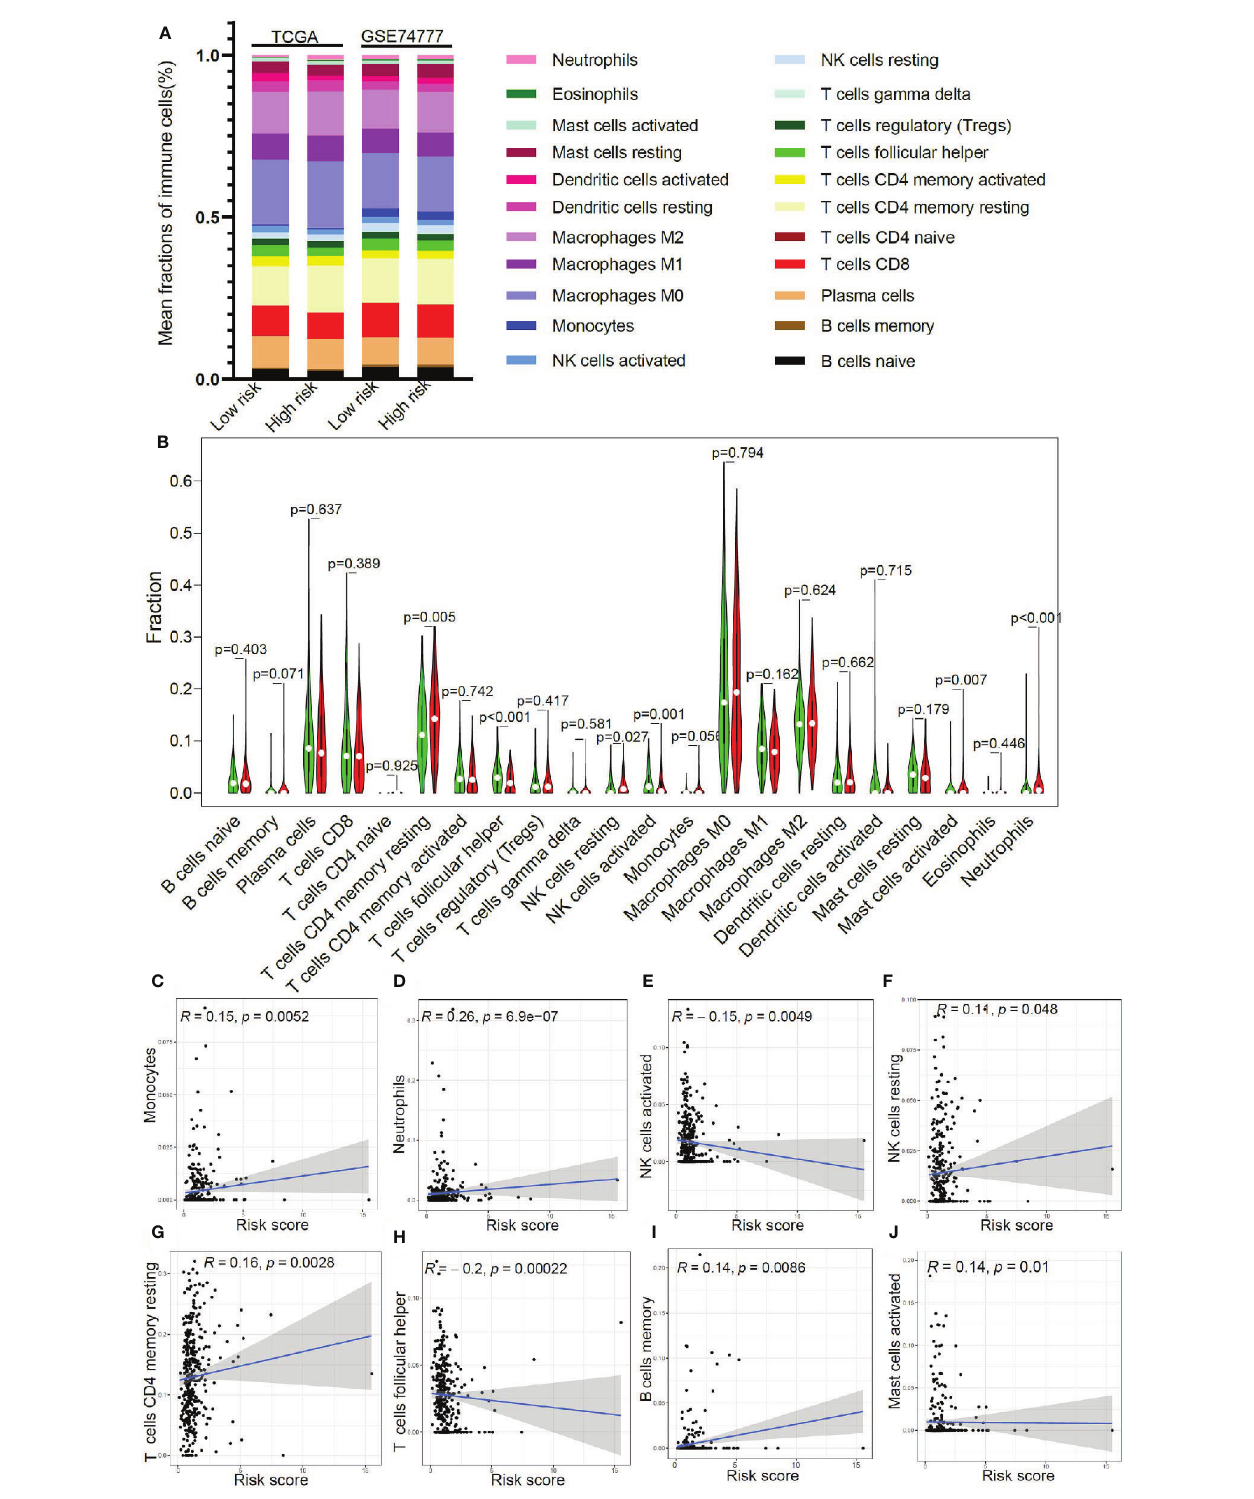
FIGURE 5 | The relationship between immune cell in fi ltration and risk score in early stage LUSC. (A) The distribution of tumor immune cell in fi ltration in high- and low- risk groups in TCGA cohort and GSE74777 set. (B) Comparison of tumor immune cell in fi ltration levels between high- and low-risk groups. (C – J) Correlation of risk score with immune cell in fi ltration levels in patients with early stage